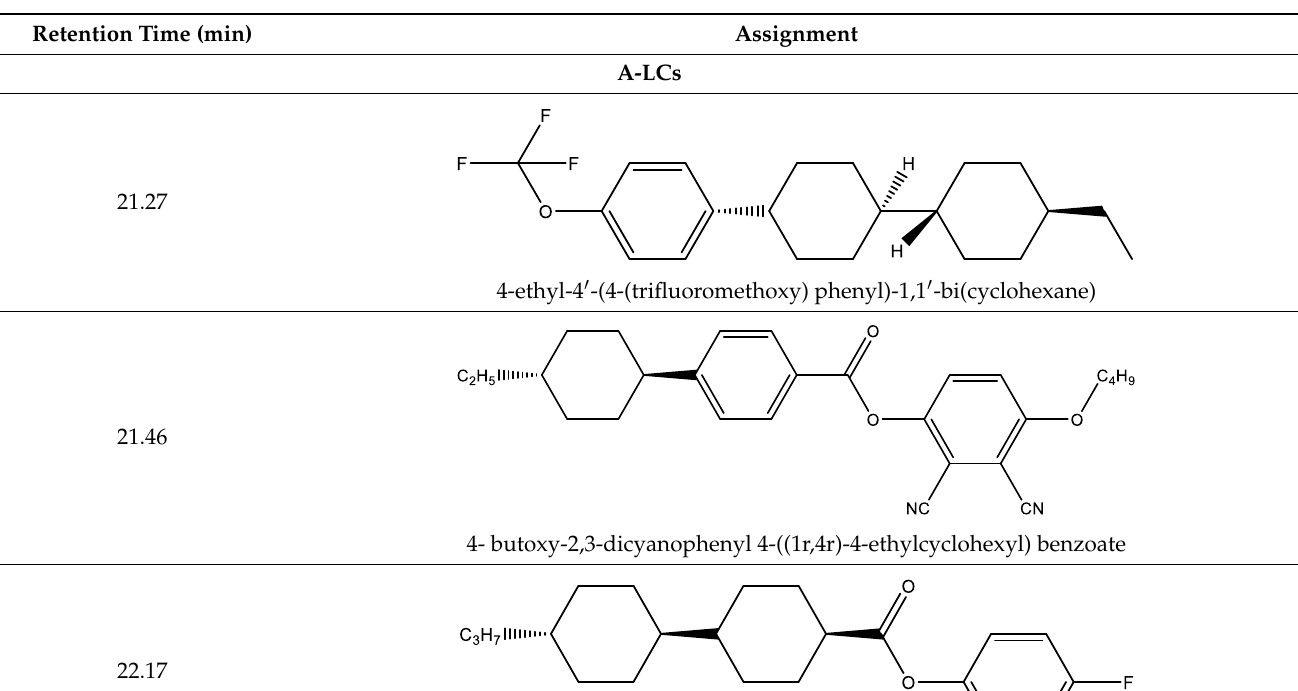
Table 3. Assignment of some peaks corresponding to LC molecules of GC chromatograms obtained from LC mixtures A and C.